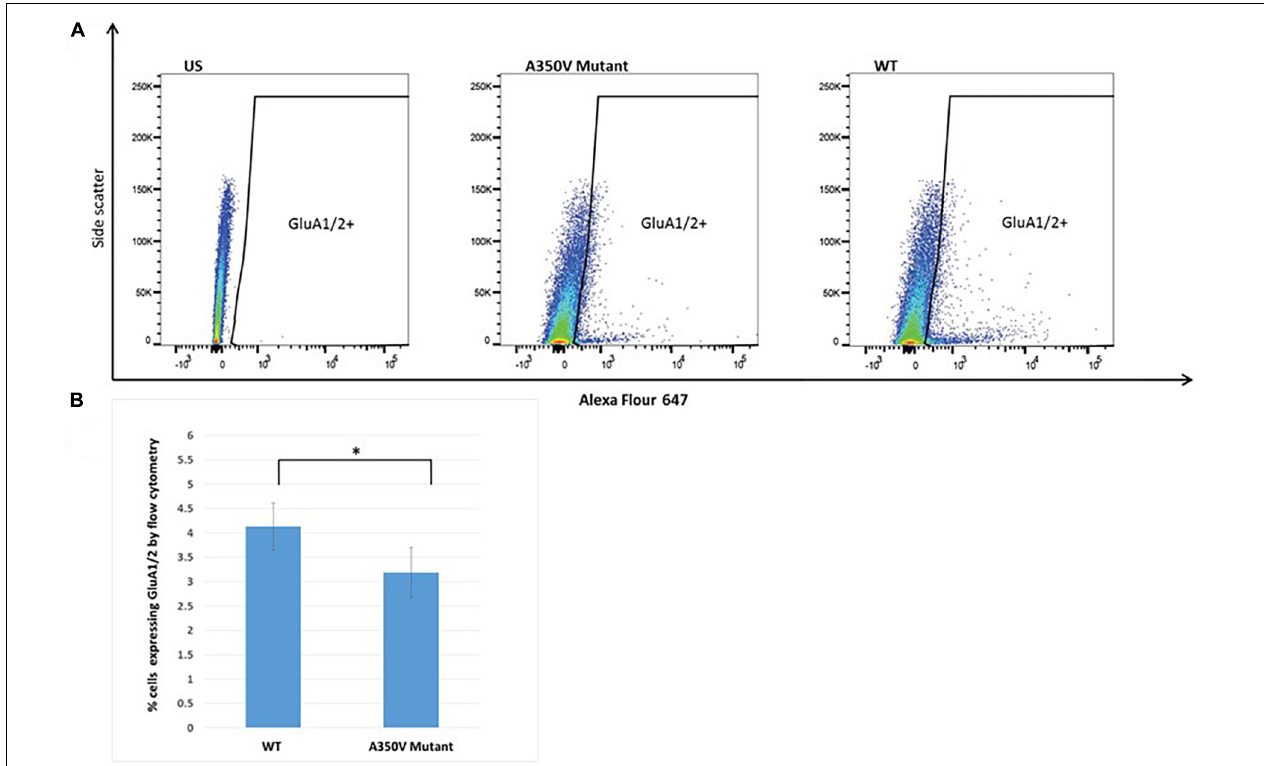
FIGURE 5 | Flow cytometry analysis of hippocampal derived cells for GluA1/2. (A) Representative dot plot of one of 10 experiments. US panel-unstained hippocampal cells. Mut and WT panels demonstrating staining with Alexa Flour 647 for extracellular GluA1/2 in single cell suspension of hippocampal cells from A350V and wild type mice, respectively, and window selected for identifying GluA1/2+ cells. (B) Summary of all experiments demonstrating significantly higher percentage of cells staining with GluA1/2 in wild type as compared to A350V mutant hippocampal neuronal preparations (4.1 ± 0.5 vs. 3.1 ± 0.5, paired t -test, n = 10 independent experiments, ∗ p <